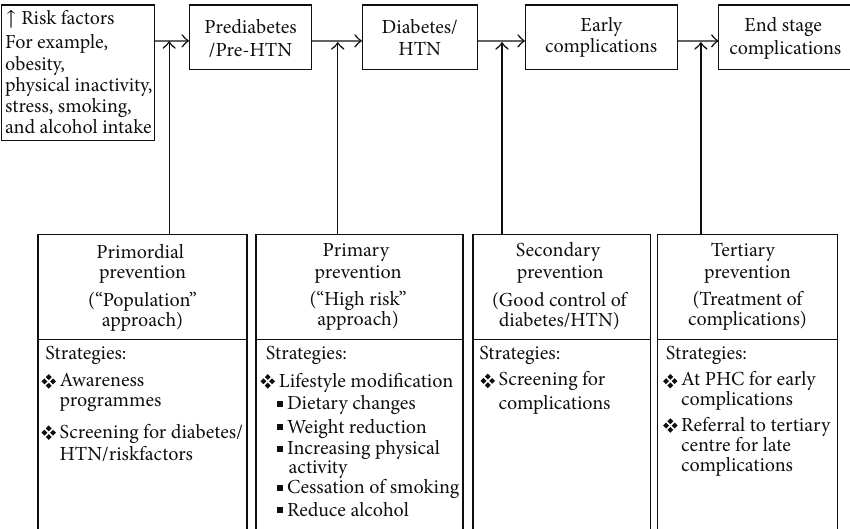
Figure 2: Strategies for prevention for diabetes and hypertension at different